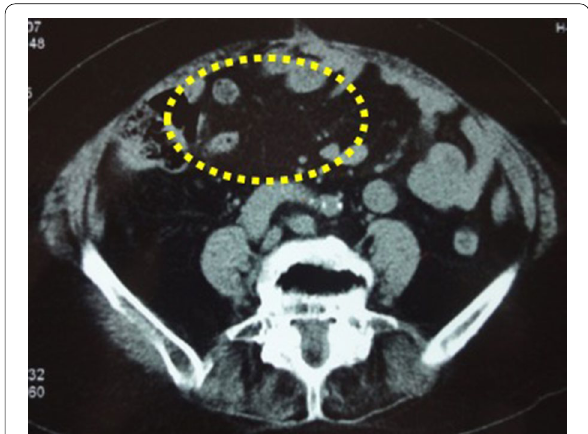
Fig. 6 Complete recovery from intra-abdominal metastasis could be confirmed by an abdominal CT scan performed 1 year after endocrine therapy was started. Spotted circle (…) show the disappearance of intra-abdominal